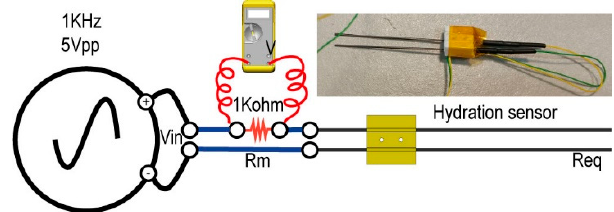
Figure 7. Technical illustration and photograph of the hydration measurement system. It consists of a function generator, a voltmeter, a resistance of 1 KOhm, and the hydration sensor.